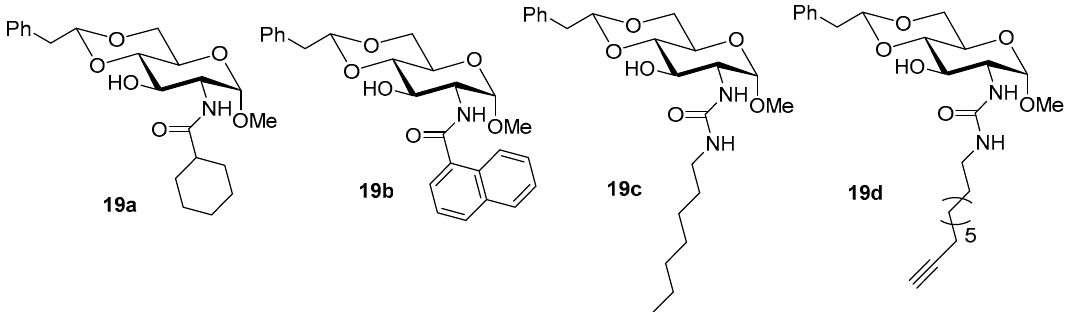
Figure 11. Structures of amide derivatives as organogelators and hydrogelators [42].